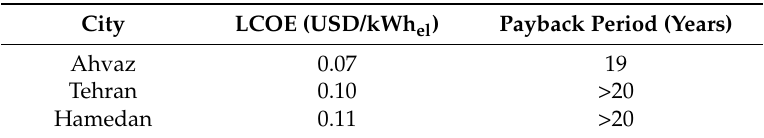
Table 8. Economy of the polygeneration system.